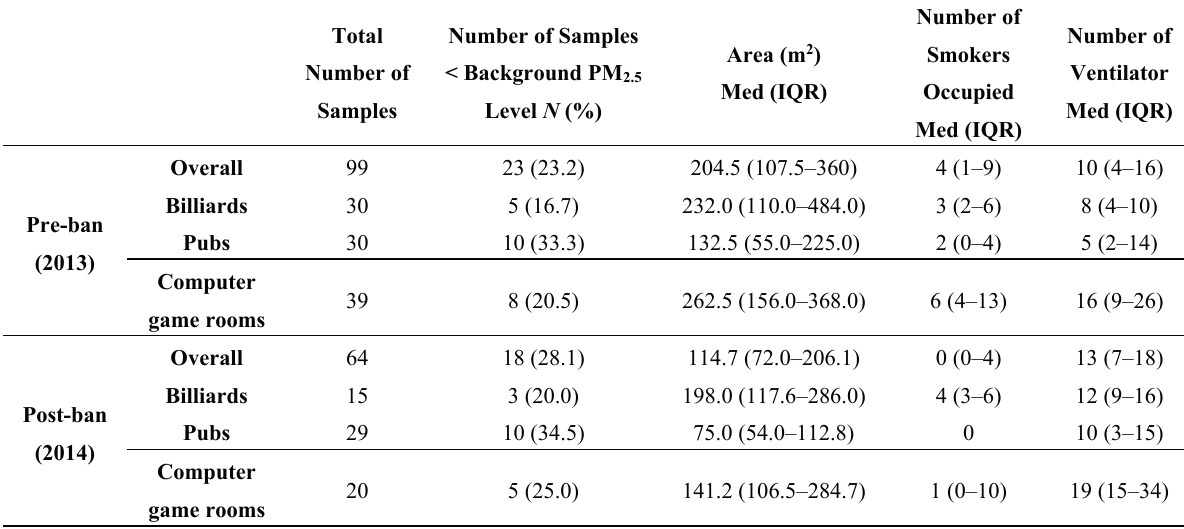
Table 1. Summary of characteristics of sampling sites including area (m 2 ), the number of smokers occupied and the number of ventilators installed